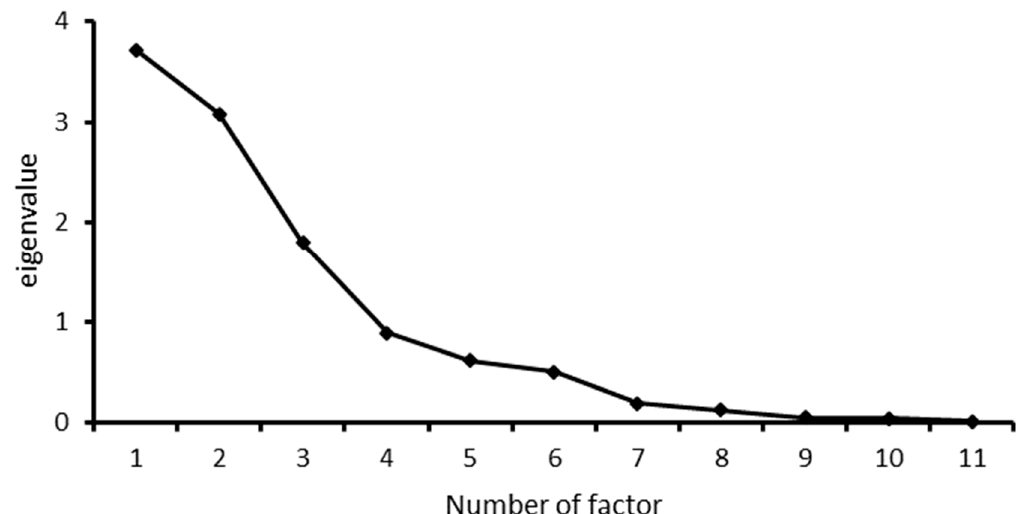
Figure 1. Scree plot showing factors that had eigenvalues >1 from a study of efficacy profiles of antimicrobials evaluated against Staphylococcus isolated from canine clinical specimens in South Africa. Table 4. Loading factors.